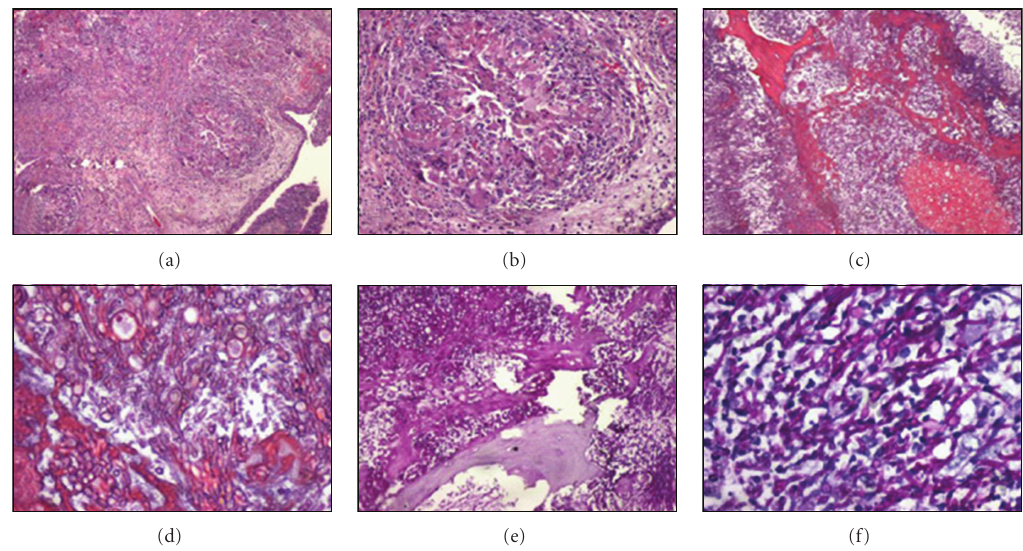
Figure 3: Ethmoiditis due to Scedosporium apiospermum . (a) Mucosa lined by respiratory type epithelium with intense inflammatory reaction (hematoxylin and eosin [H&E] staining, magnification × 100); (b) higher magnification ( × 400) of (a) it can be identified numerous epithelioid granulomas and multinucleated giant cells; (c) partially destroyed bone tissue and numerous fungal hyphae (H&E staining, magnification × 100); (d) morphologically the fungal hyphae resemble Aspergillus spp . (H&E, magnification × 400); (e) bone tissue destruction by fungal hyphae (PASstaining,magnification × 100); (f) the main host response is a mixed neutrophilic and monocytic infiltrate (PAS staining, magnification ×